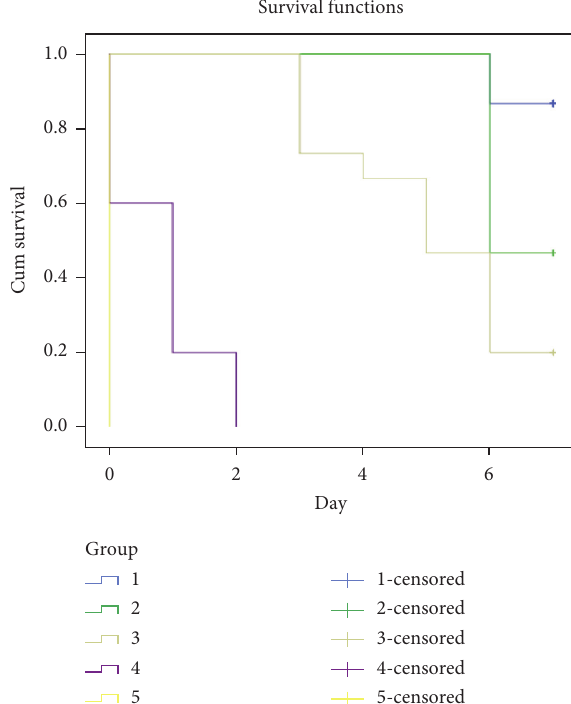
Figure 2: Subchronic toxicity effect of arsenic on the survival rate of adult Javanese medaka treated with different concentrations of arsenic (0.05–1.75mM). The percentage of survival rate is shown versus concentration of arsenic. ∗ P < 0 . 01 represents significant different values of the control group and group exposed to arsenic. The values represent mean ± SD from three ( n � 3) independent